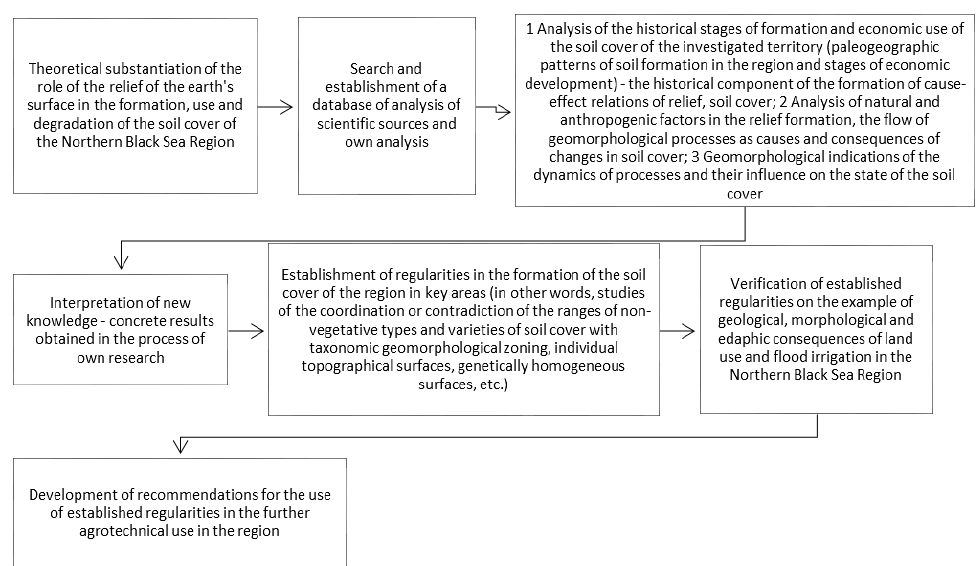
Fig. 1. Algorithm of ecological and geomorphological analysis of the formation, use and degradation of soil cover in the central part of the Northern Black Sea